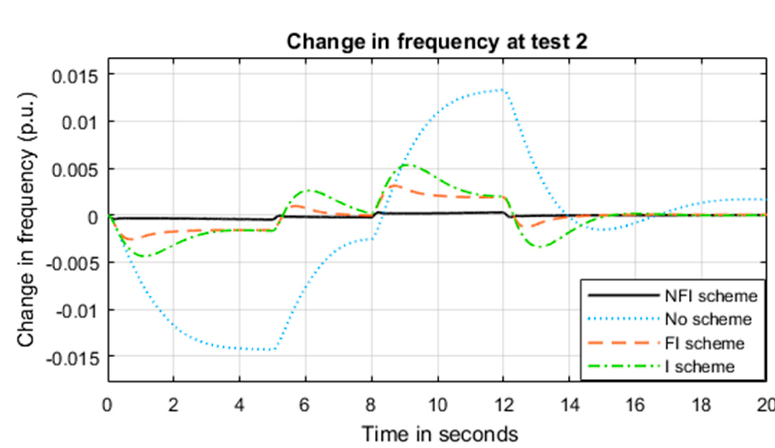
Figure 17. Change in frequency in test 2.